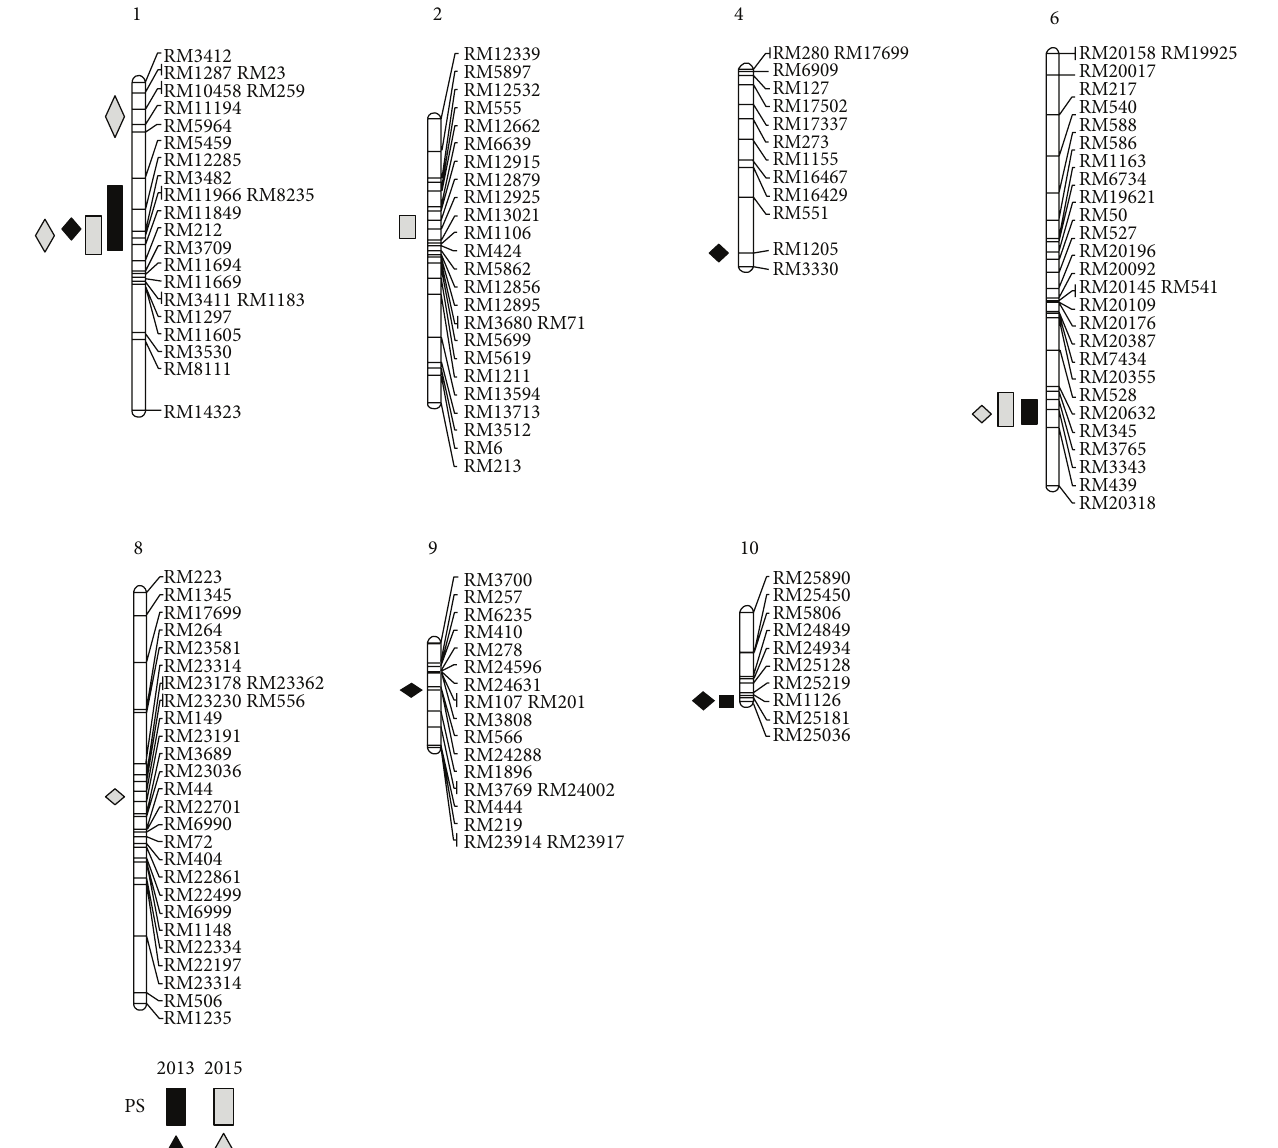
Figure 3: The chromosomal locations of the QTLs related to pulling strength (PS) and bending strength (BS) in 2013 and 2015. The rectangles and diamonds are the QTL associated with pulling and bending